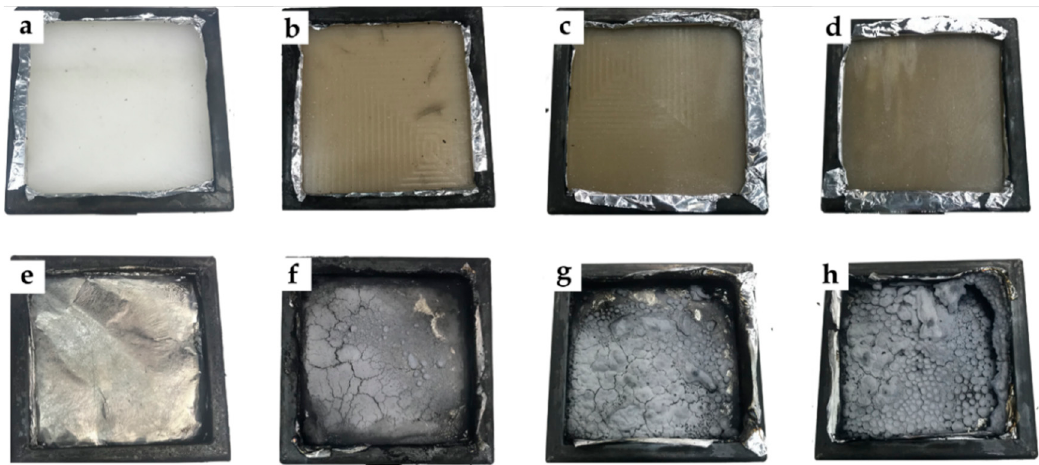
Figure 8. Visual di ff erence between samples before and after the CCT test: ( a ) PA1010 before, ( b ) PA1010 / 10HNTs before, ( c ) PA1010 / 20HNTs before, ( d ) PA1010 / 30HNTs before and ( e ) PA1010 after, ( f ) PA1010 / 10HNTs after, ( g ) PA1010 / 20HNTs after, ( h ) PA1010 / 30HNTs after.